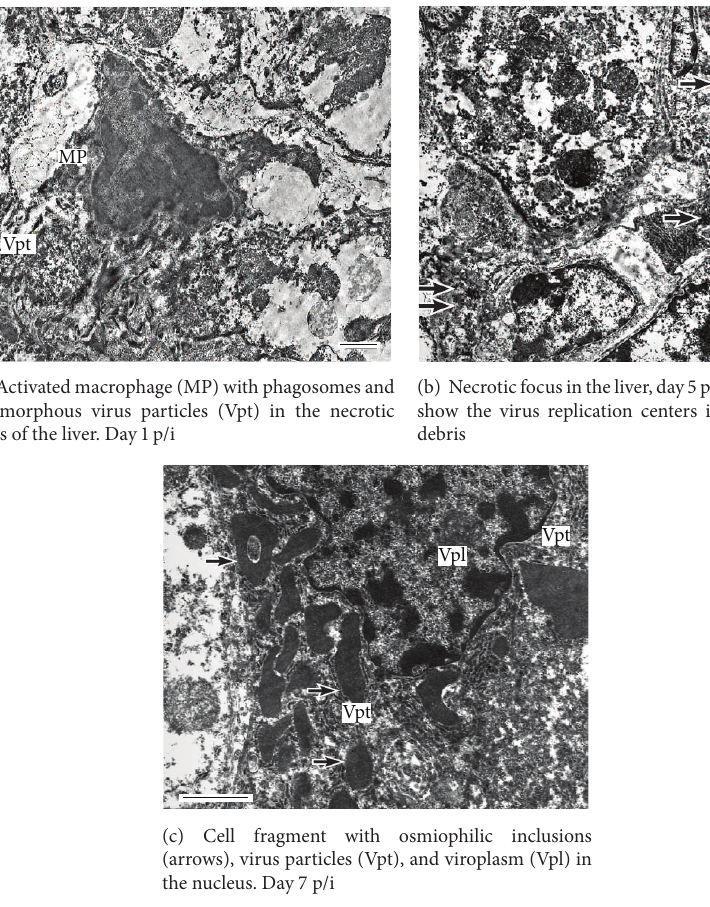
Figure 2: Wild-type EBOV nonlethal infection in guinea pigs. Electron microscopy of the